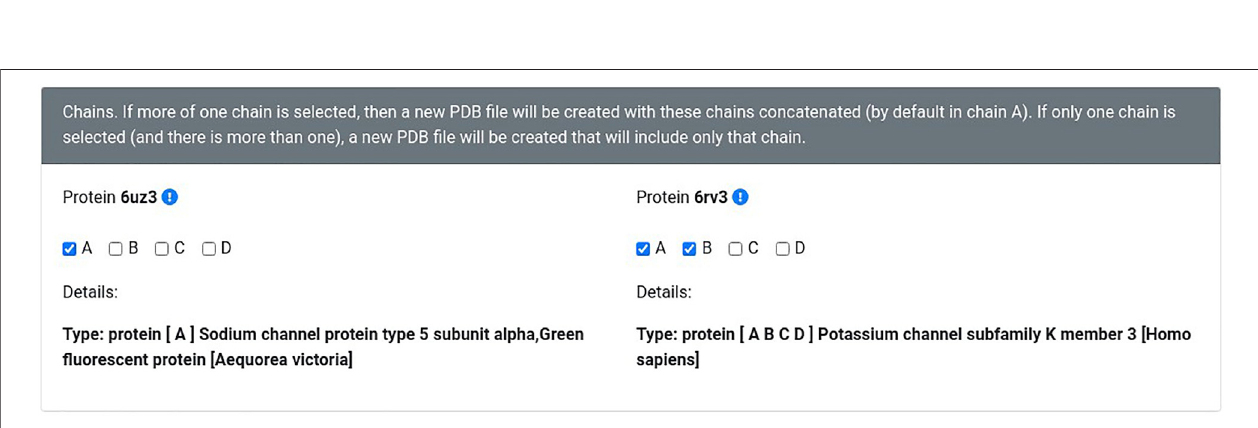
FIGURE 2 | The user can concatenate different protein chains. The information concerning chains, names, and the source organism of each protein is obtained from the Protein Data Bank or from the same PDB fi le (in the case of homology models).